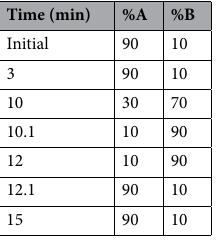
Table 1. Gradient